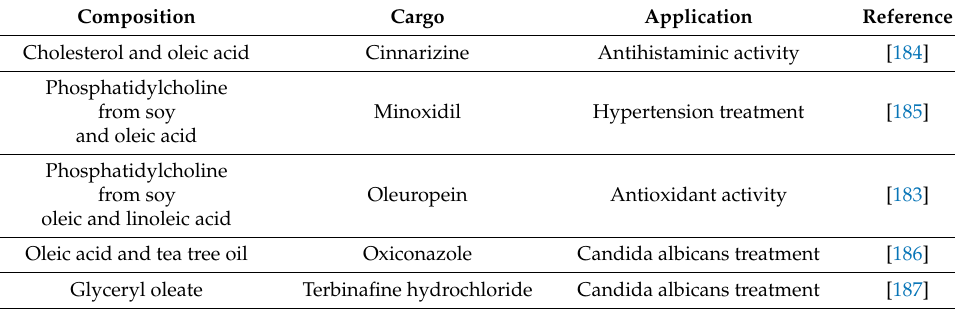
Figure 6. Schematic structure of ufasomes lipid vesicular system. Table 6. Ufasomes’ drug delivery applications.